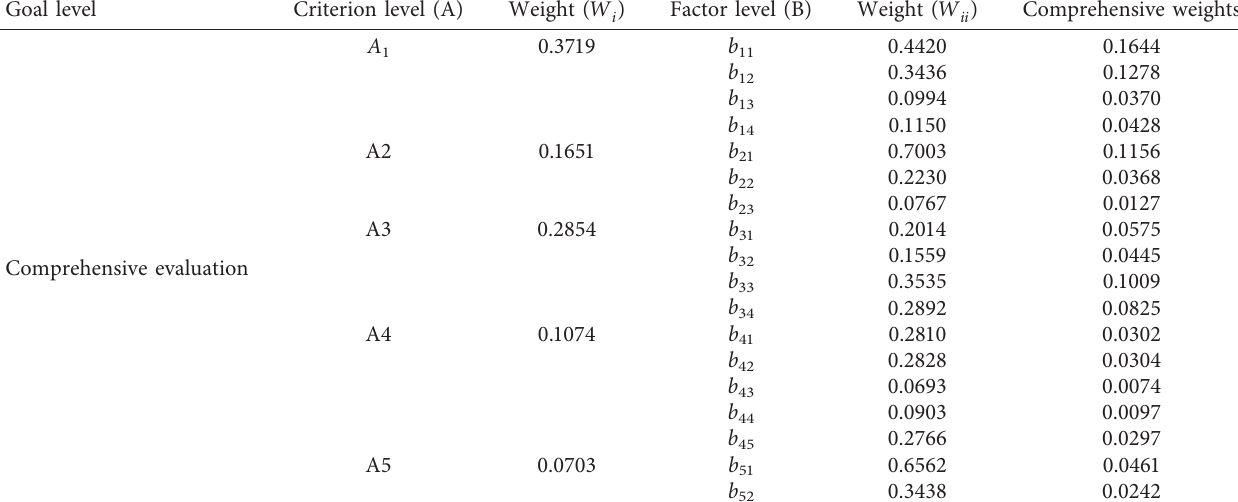
Table 2: Weight value of the comprehensive evaluation index of hydrogen production technology.